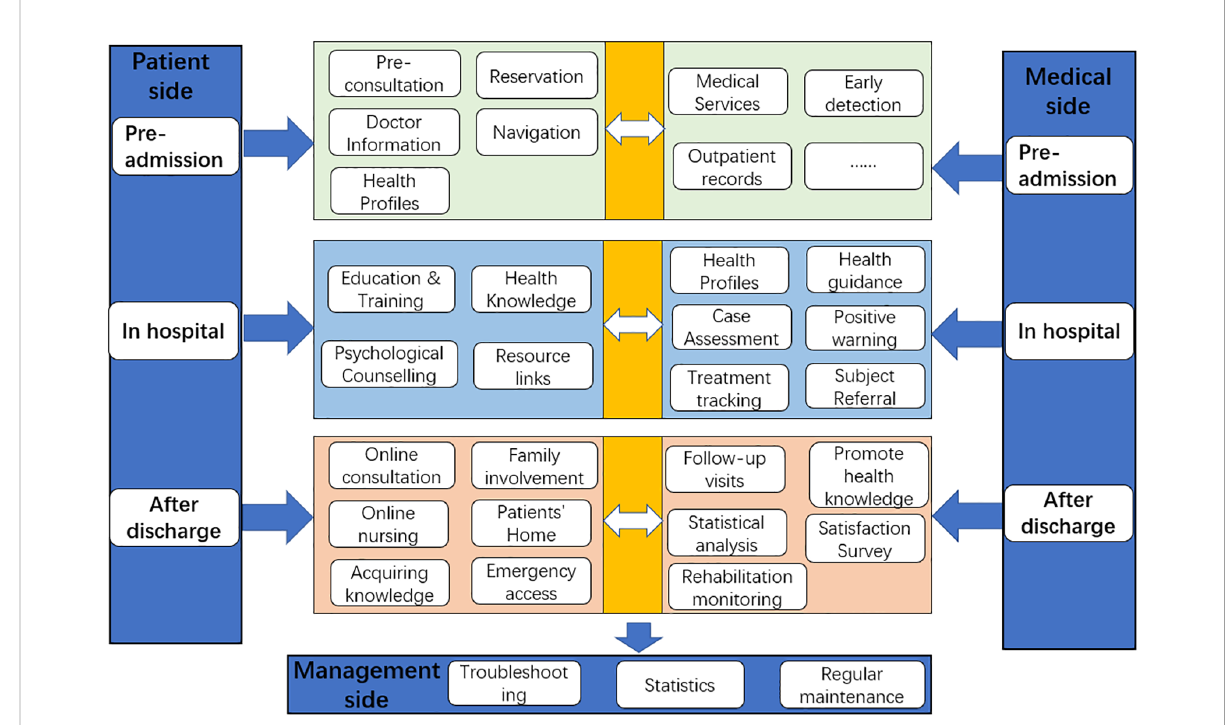
FIGURE 1 Framework for a case management information platform for breast cancer patients.